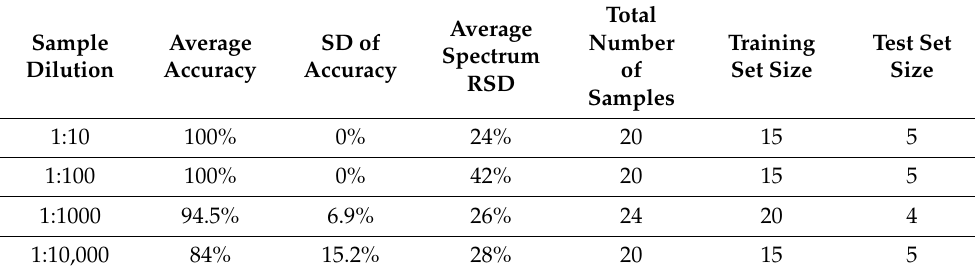
Table 3. Results of spectra differentiation by the algorithm at different influenza A virus dilutions.